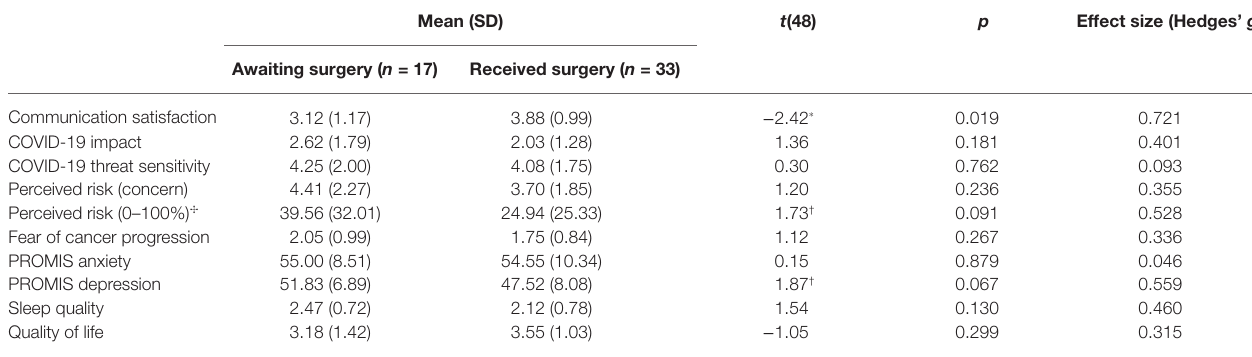
TABLE 4 | Means of continuous variables by cancer surgery